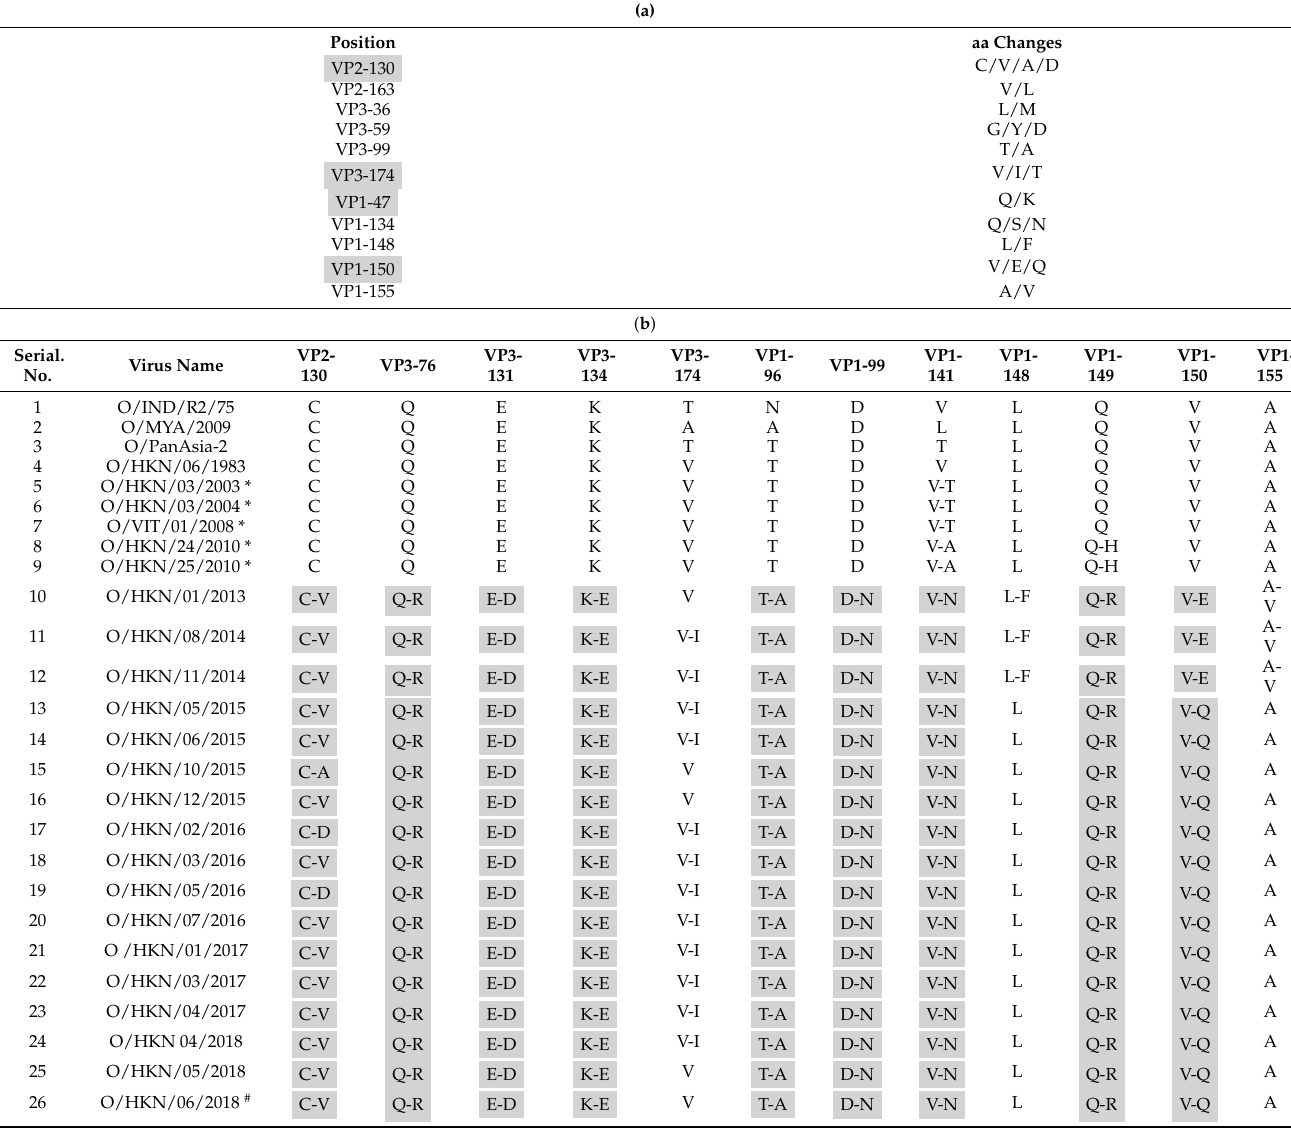
Table 3. ( a ). Capsid positions with high variability scores (>0.6) and corresponding aa changes. The residues with scores above 0.9 are shaded gray. aa: amino acid. ( b ) Capsid sequence changes observed in Cathay serotype O viruses used in this